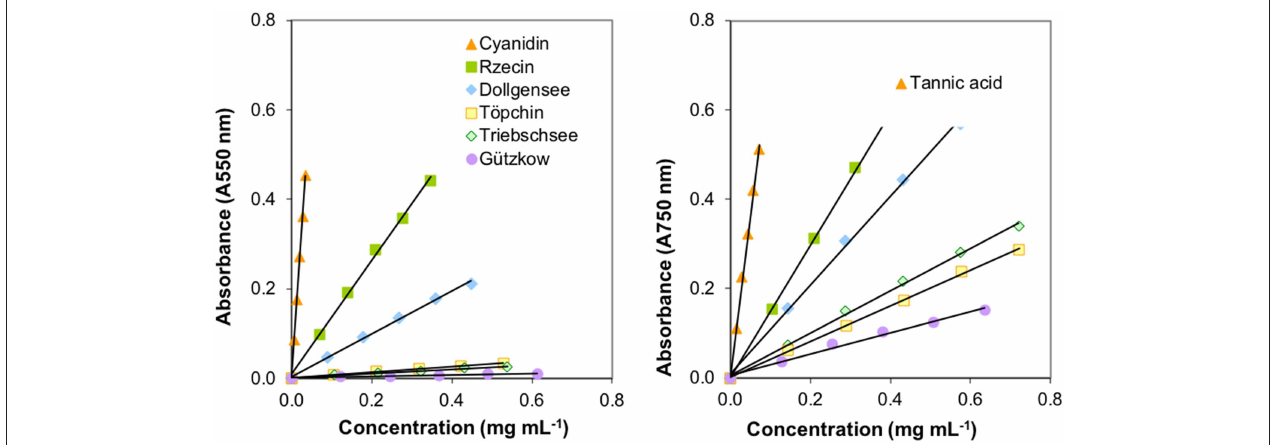
FIGURE 4 | Calibrations of the acid butanol (left image) and the Folin-Ciocalteau assay (right image) with isolated tannins from less decomposed peat of pristine peatlands.